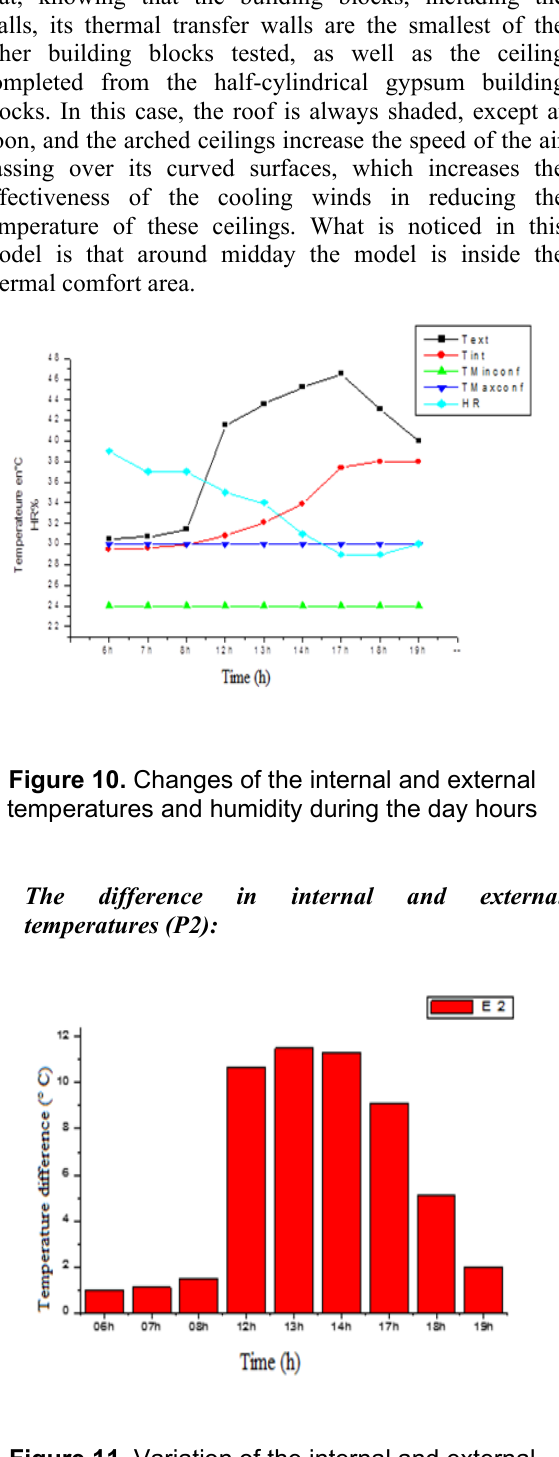
Figure 11. Variation of the internal and external temperatures during the day.